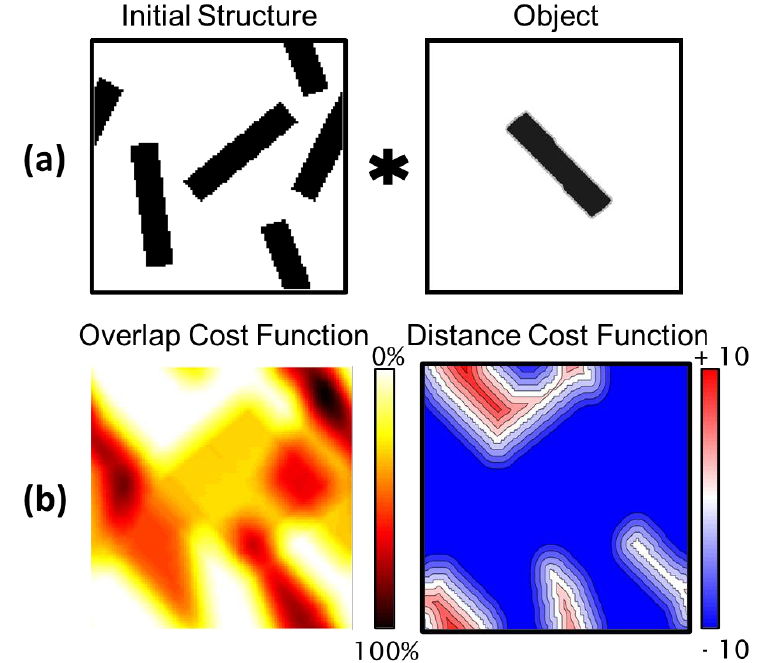
Figure 2. ( a ) Initial structure before object placement (left) along with the object to be placed (right). ( b ) Illustration of the computation of the overlap cost function (OCF) and the distance cost function (DCF). bracelets